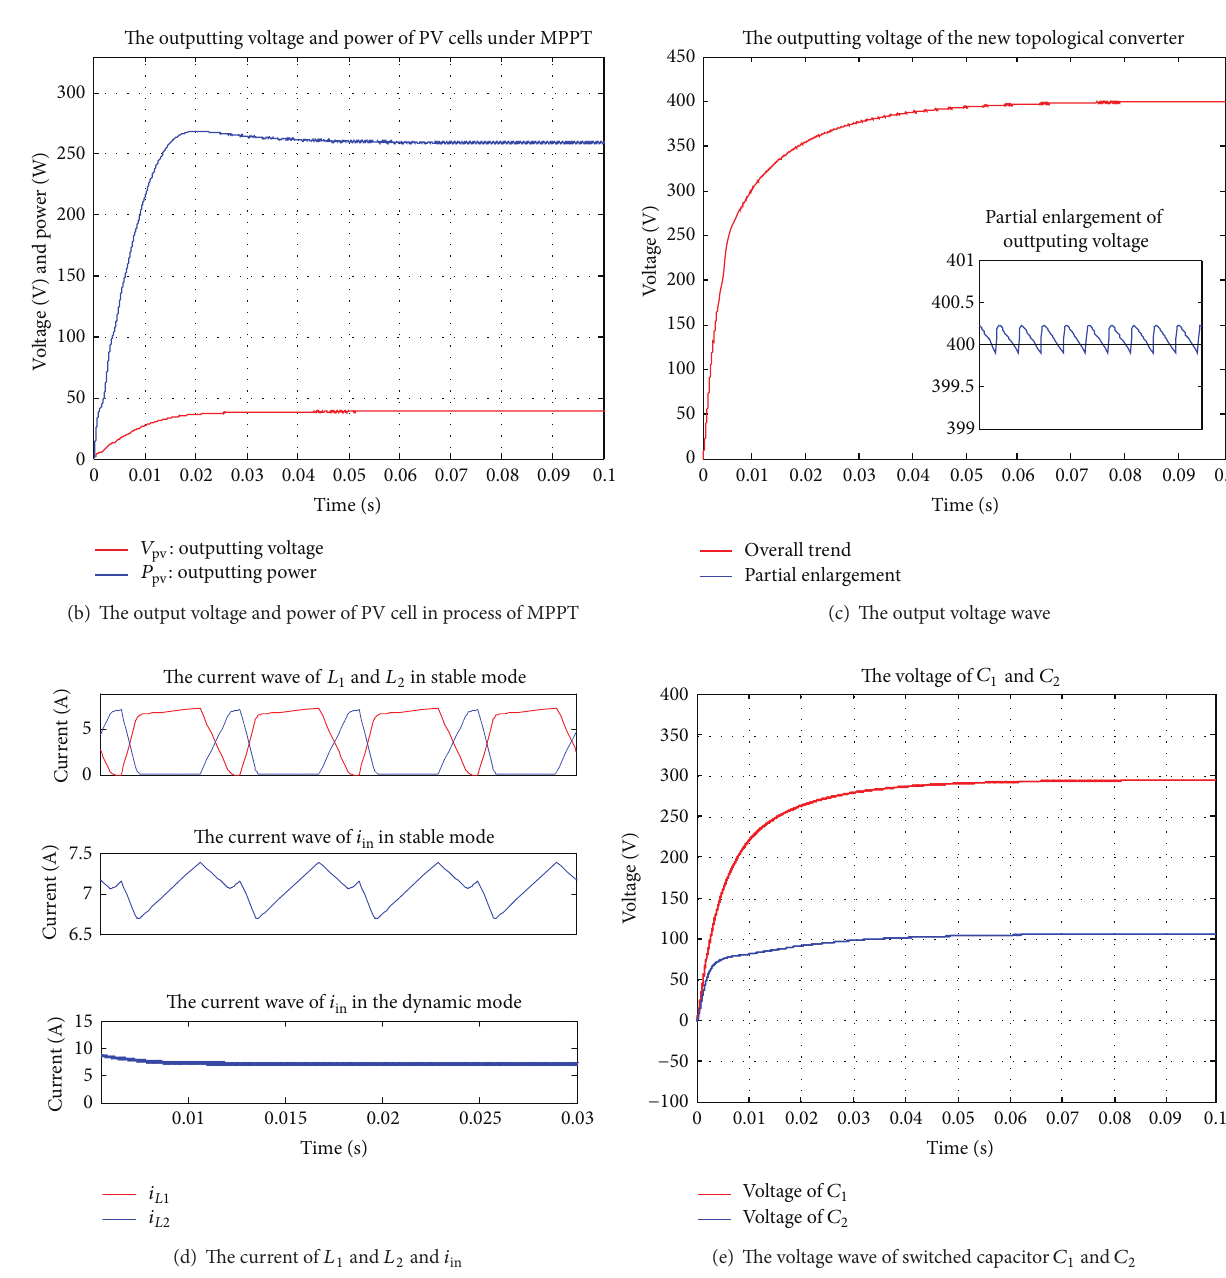
Figure 10: Simulation